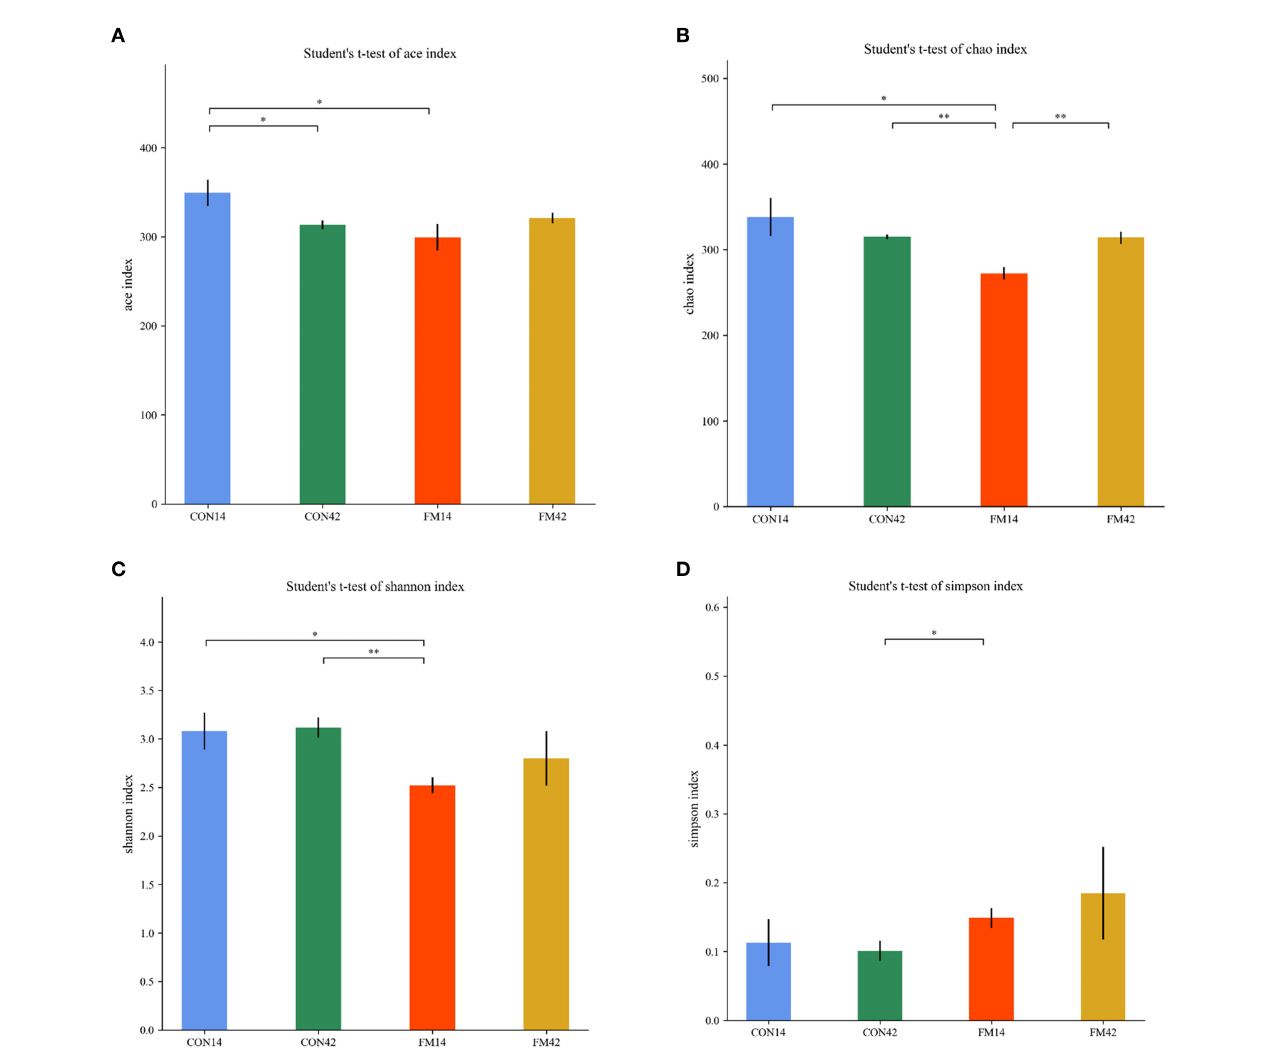
FIGURE8 Comparison of fecal microbiota structure by α -diversity [ (A) : ace; (B) : chao; (C) : shannon; (D) :